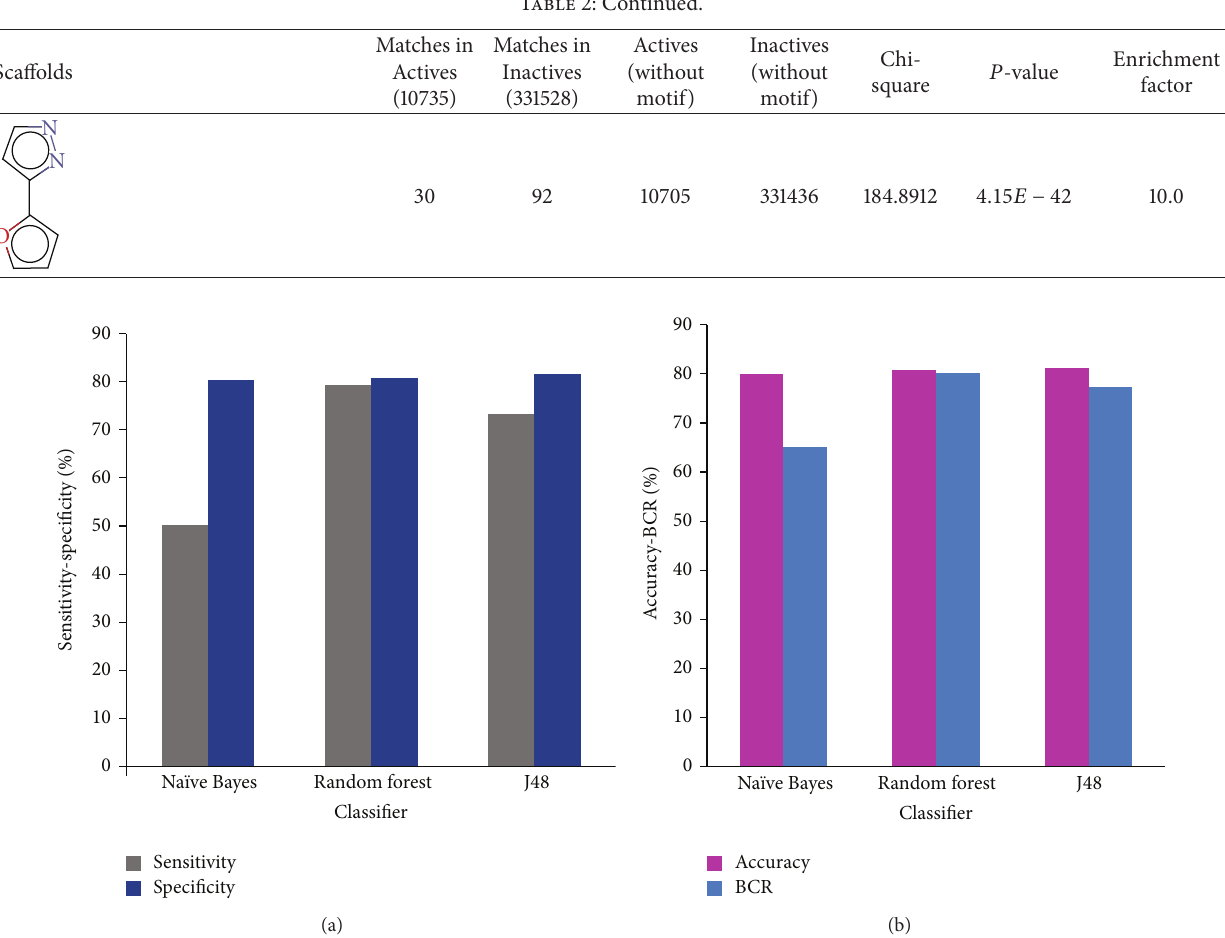
Figure 1: Comparison of the performance of the models of na¨ıve Bayes, random forest, and J48 based on (a) sensitivity and specificity and (b) accuracy and BCR.